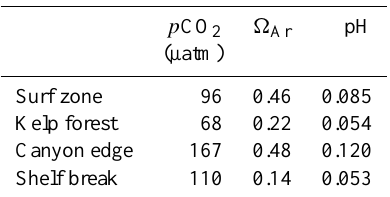
Table 3. Mean daily range of carbonate parameters at in situ condi- tions for 2012 at each